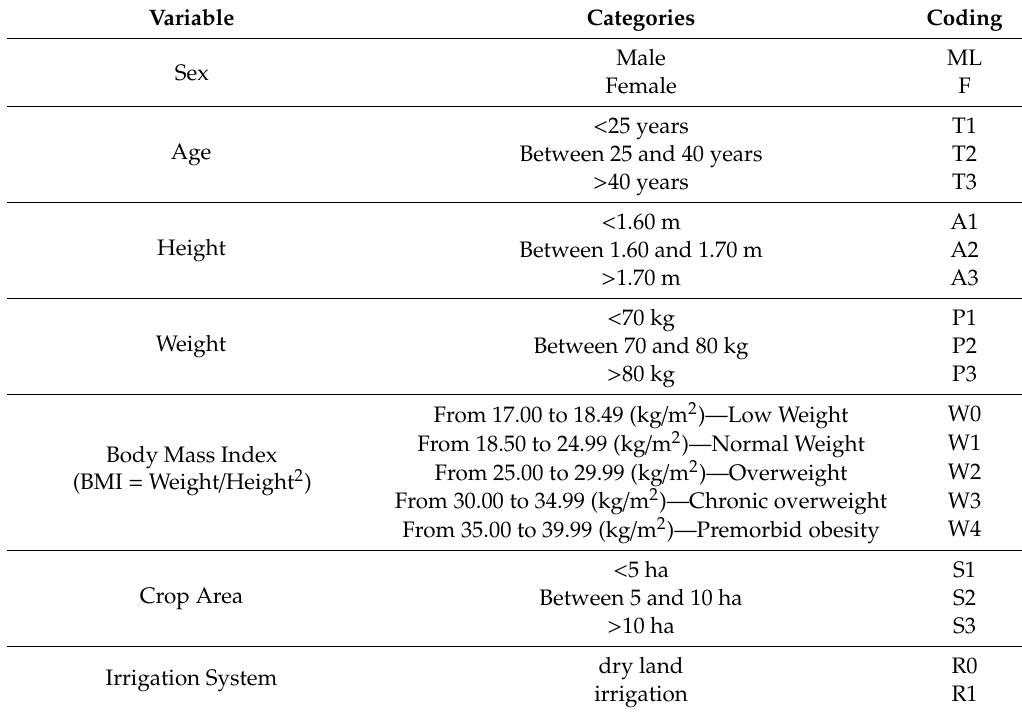
Table 3. Qualitative variables of the workers and their